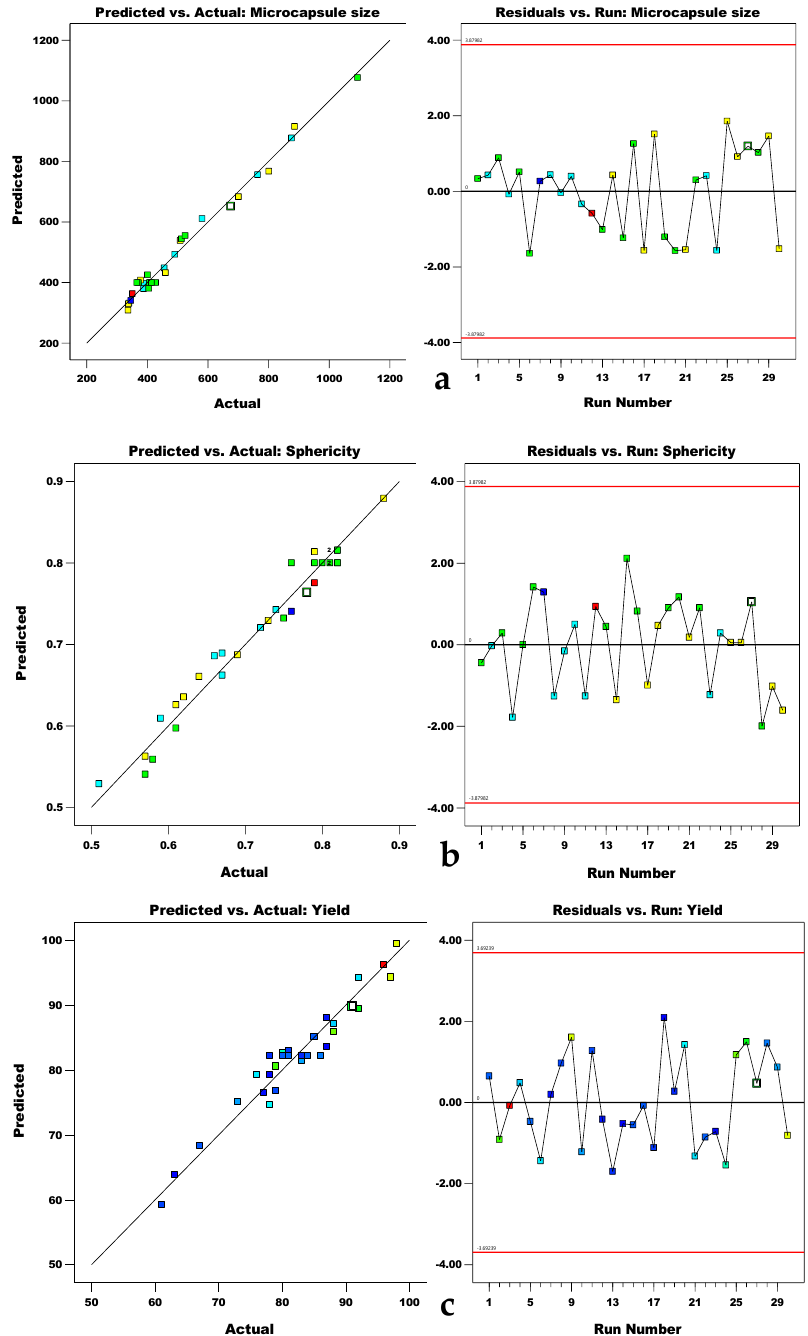
Figure 1. Linear correlation plots for predicted and experimental values and residual plots for ( a ) microcapsule size, ( b ) sphericity, and ( c ) yield. The values of the response variables were predicted from coefficients of polynomial equation computed from experimental data. The quadratic regression equations for micro- capsule size and sphericity, and 2FI for yield are stated in Equations (6)–(8): Microcapsule size ( mm ) = 7461.68 − 1529.63Y 1 − 54.4689Y 2 − 328.725Y 3 + 210.343Y 4 + 0.269231Y 1 Y 2 + 33.15Y 1 Y 3 + 17Y 1 Y 4 + 1.3Y 2 Y 3 −